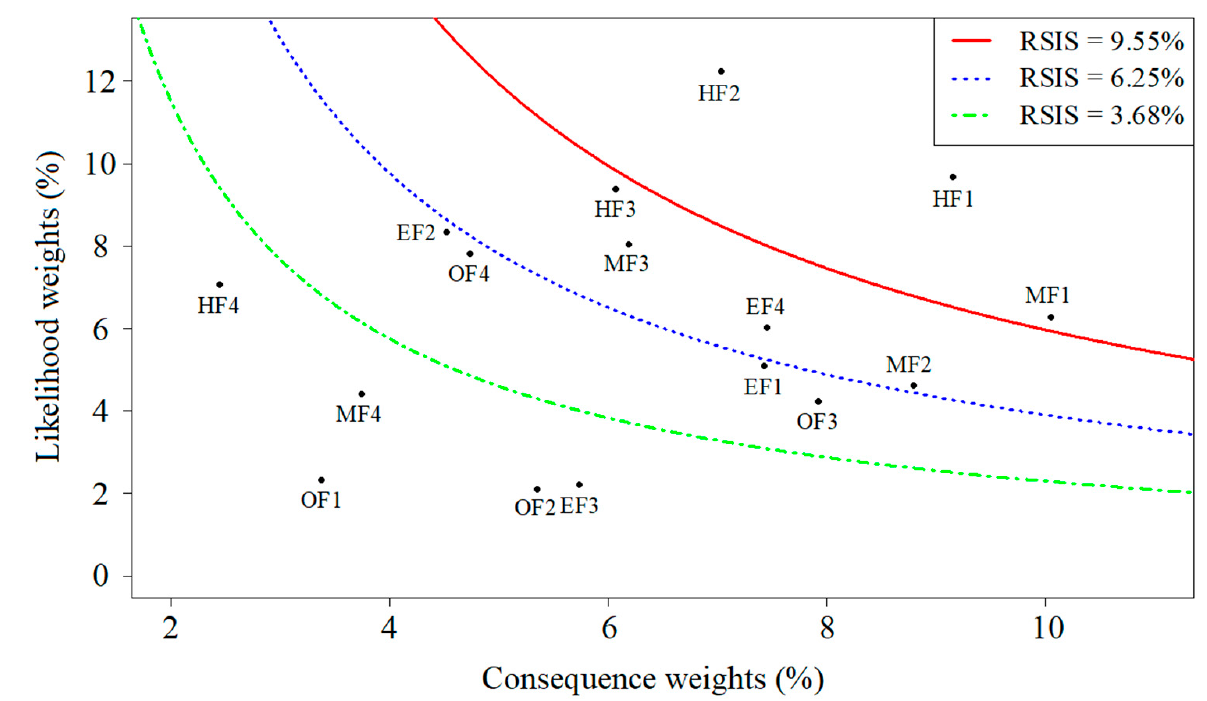
Figure 4. The RRM of flight training.